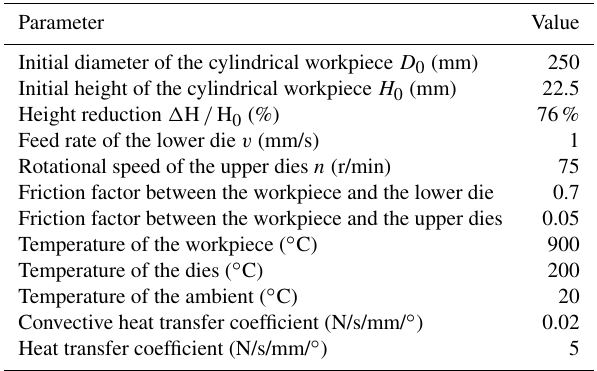
Table 2. Processing parameters for simulation of rotary forging with DSRs.